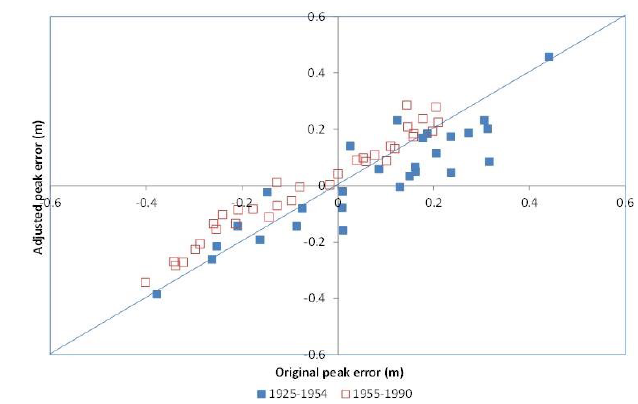
Figure 2. Illustration of the reduction in annual peak level errors for Lake Victoria at a lead time of 5 months when using a regression model for the forecast residuals linked to climate indices (adapted from Sene et al.,